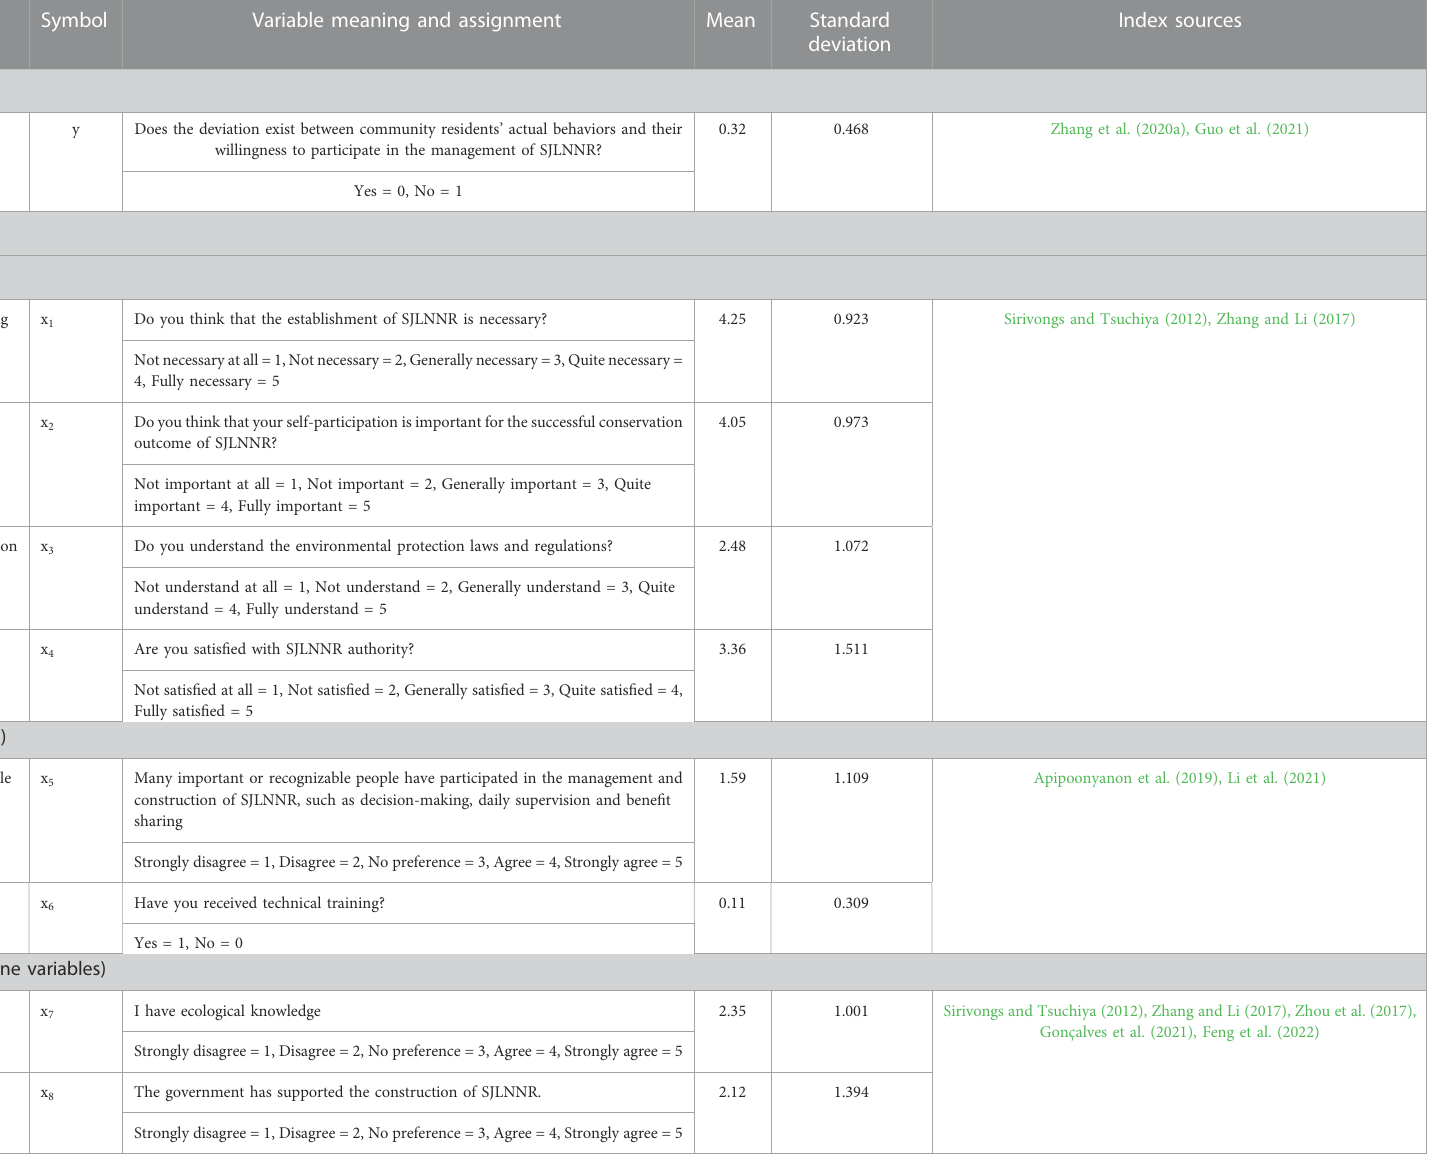
TABLE 2 Variable de fi nition and descriptive